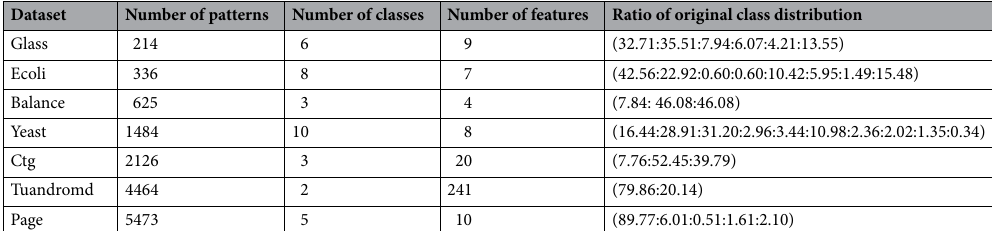
Table 1. Overview of the imbalance datasets in the experiments.